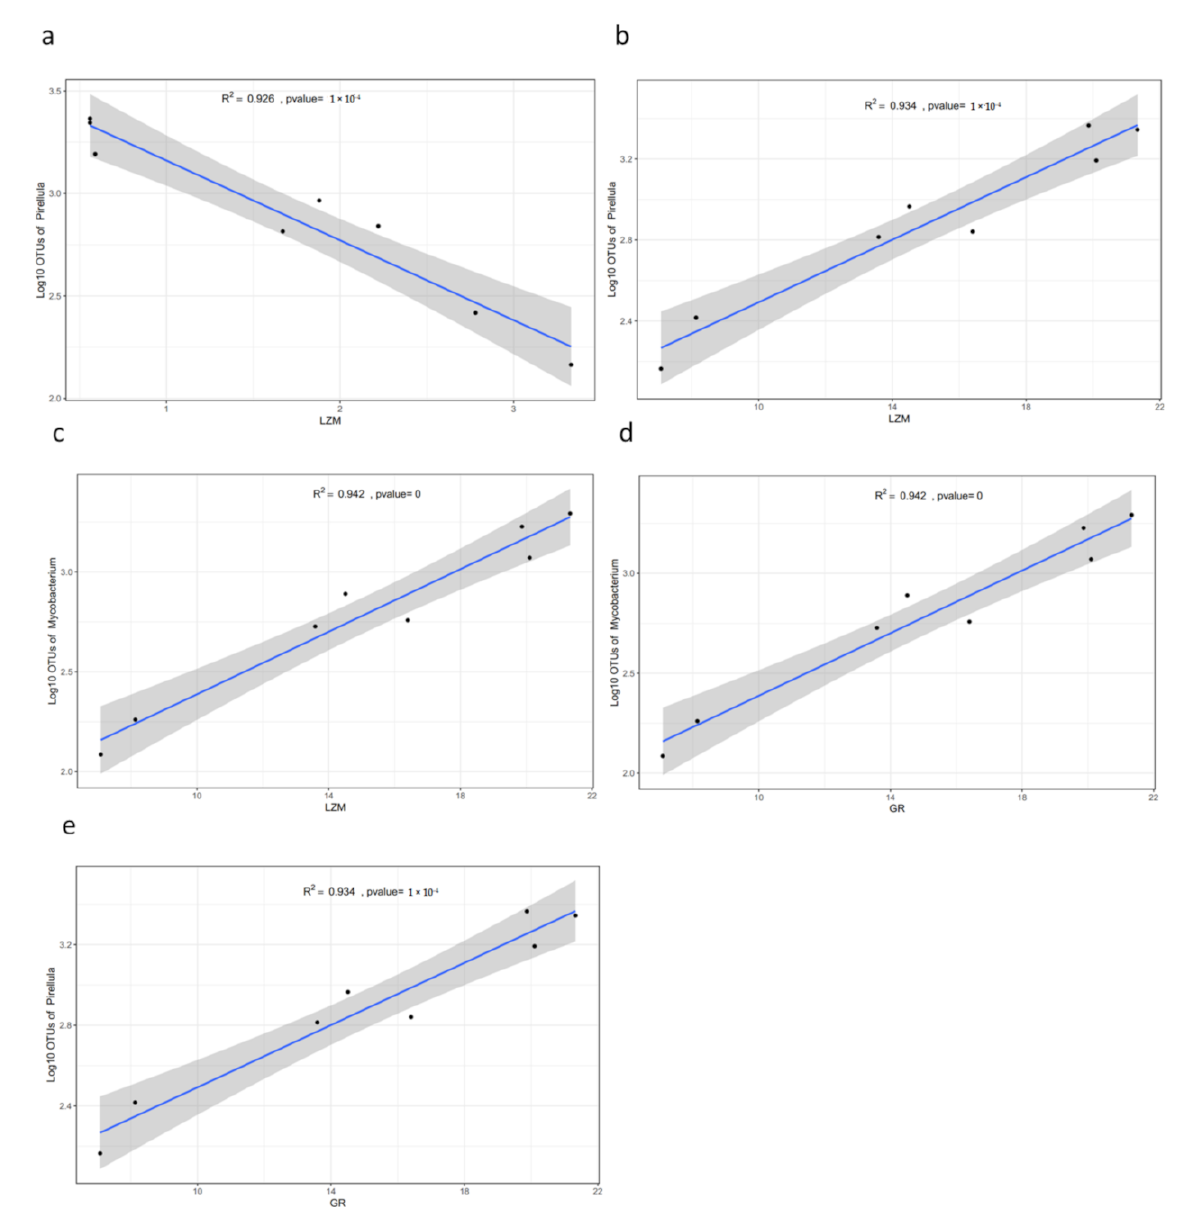
Figure 4. Scatter plot ( a – e ) showing the top 5 Pearson correlation coefficient between genus taxonomy and enzyme activities. a, in hepatopancreas; b–e, in the spleen. X -axis, enzyme activity indicator; Y -axis, log10 value of OUT abundance. LZM, lysozyme; GR, glutathione